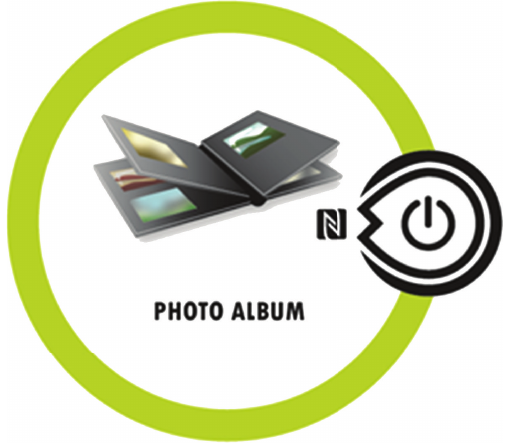
Figure 7: A service advertisement for a photo album service presenting photographs on a wall display.